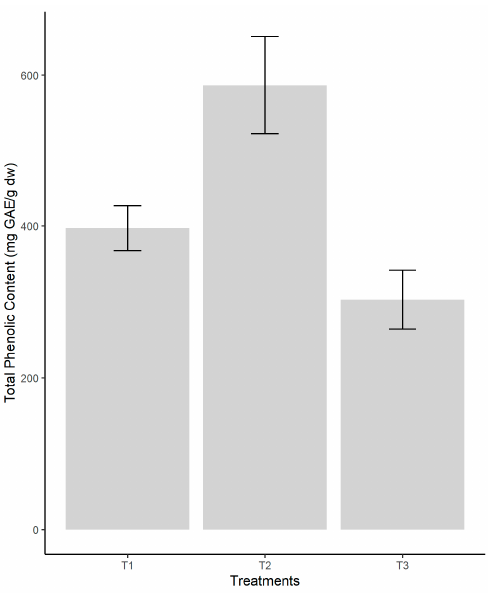
Figure 4. Comparison of the Total Phenolic Content according to the substrate used in the cultivation of P. ostreatus. Legend: T1—pine sawdust; T2—coconut coir; T3—waste paper.